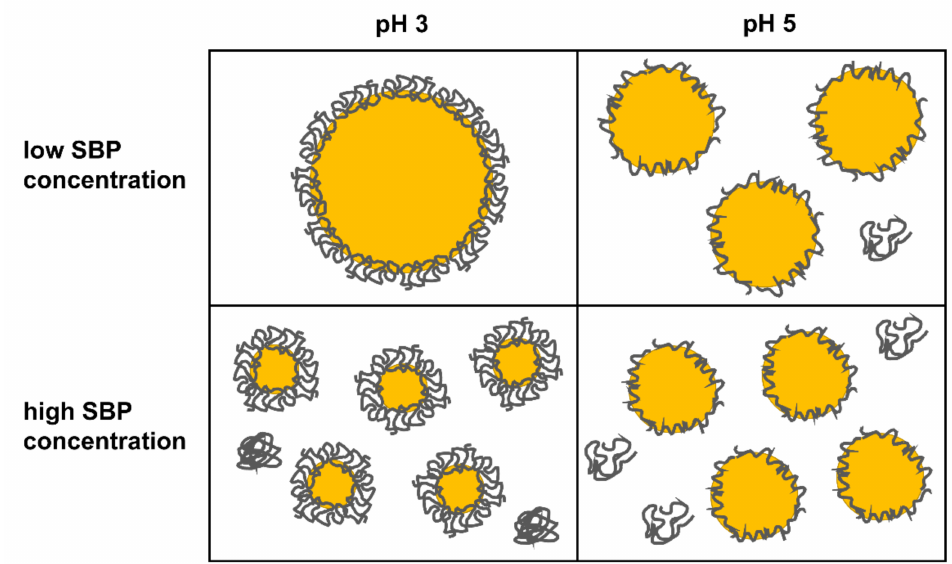
Figure 5. Schematic illustration of sugar beet pectin’s oil droplet stabilization at pH 3 (compact conformation) and pH 5 (unfolded